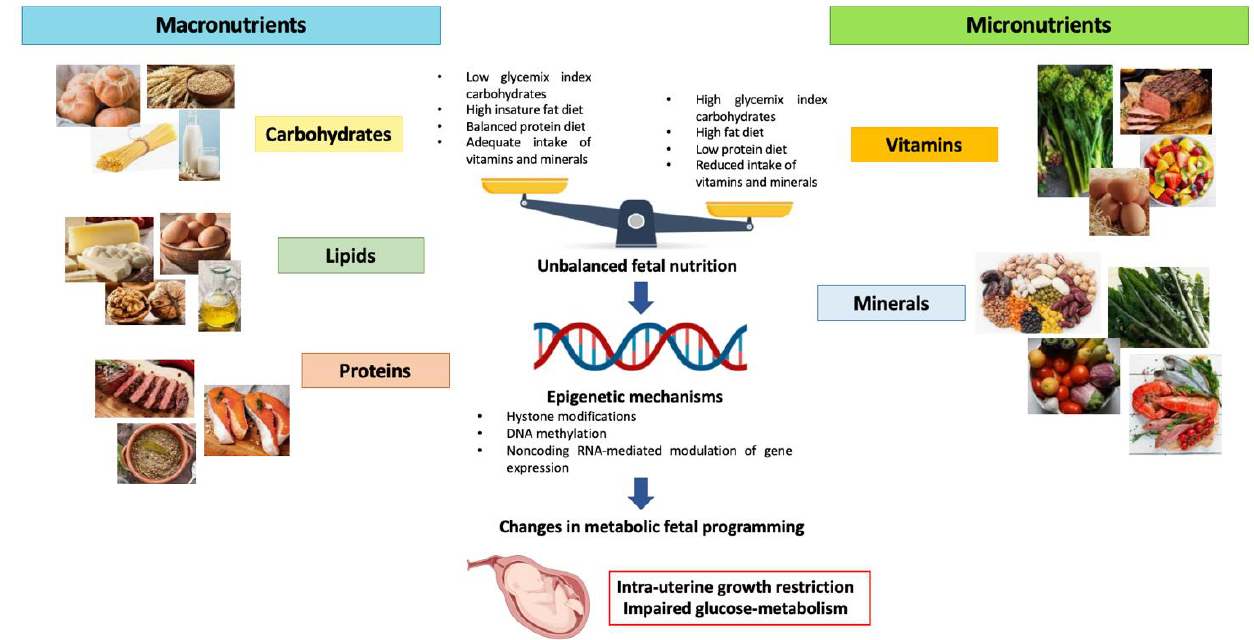
Figure 1 . Effects of unbalanced maternal nutrition on intrauterine fetal growth and fetal metabolic